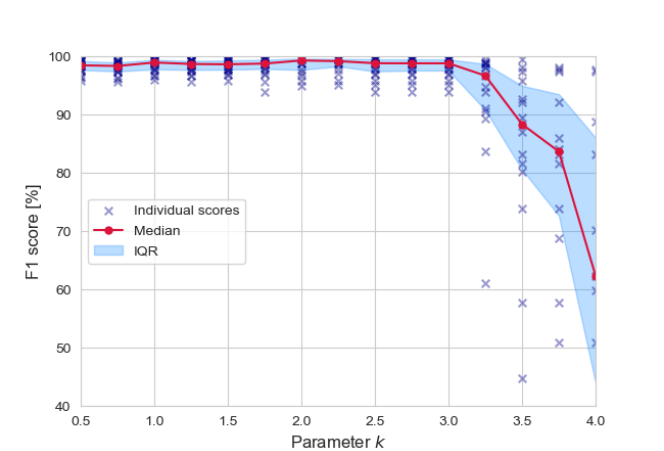
Figure 2. Beat detection performance (F1score = 2 · ( Precision · Sensitivity ) / ( Precision + Sensitivity ) ) as a function of the parameter k in Equation